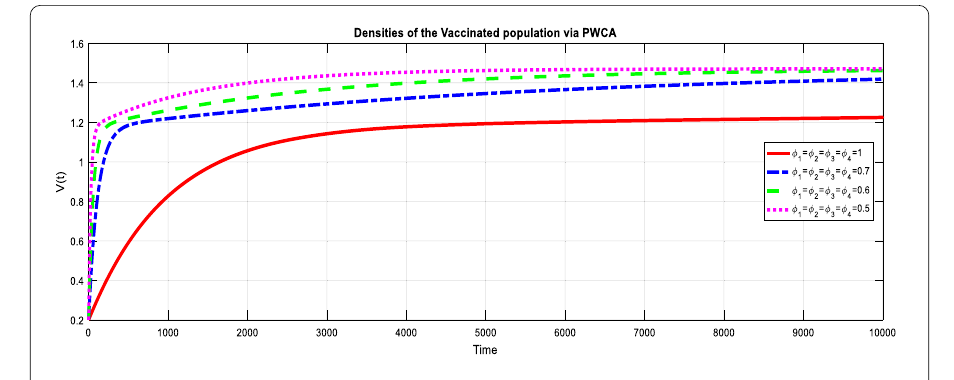
Figure 12 Dynamic of V ( t ) by varying the value of φ